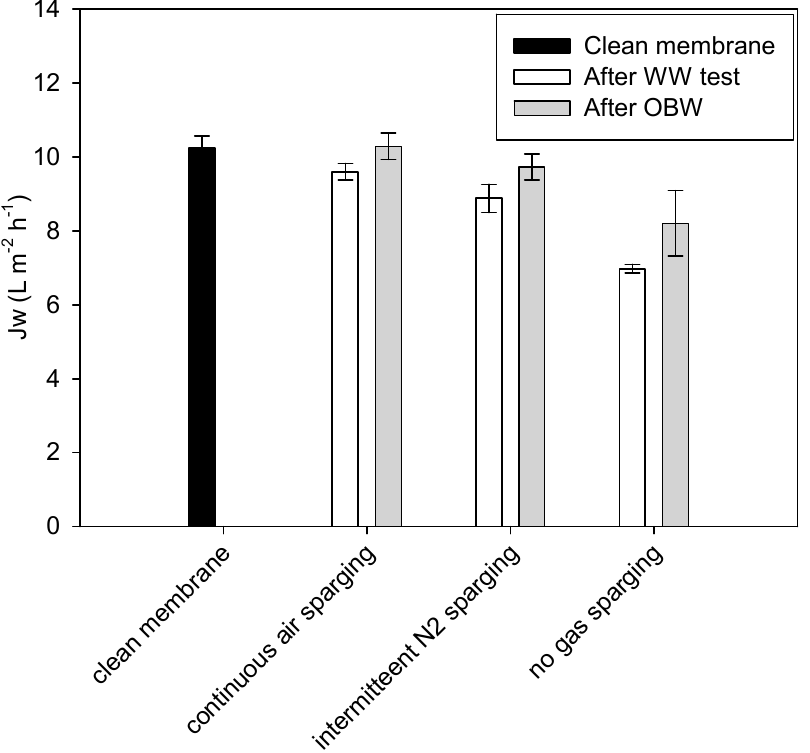
Figure 6. Comparison of water fluxes results of the flux test with clean membrane, after WW tests and after osmotic backwash (OBW). Effect of gas sparging procedure on Jw. (Tests conducted with 35 g/L salt in the draw solution)